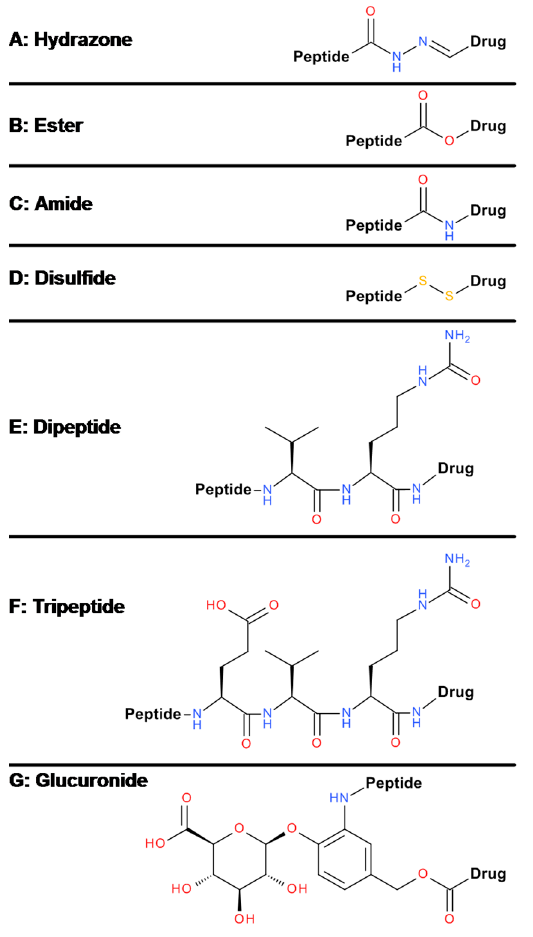
Figure 8. Linker technologies in peptide-drug conjugates.